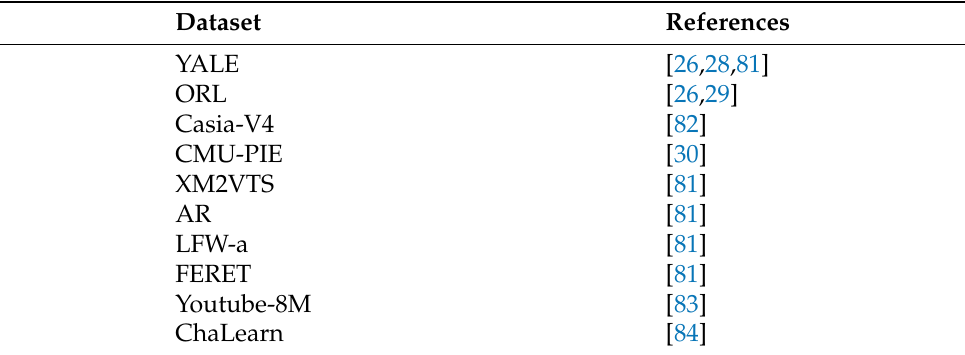
Table 6. The datasets for face recognition that were reported in the primary studies.